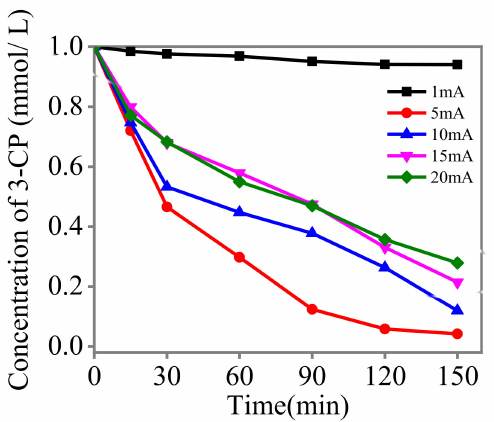
Figure 12. Effect of reduction current on the variation of the 3-CP